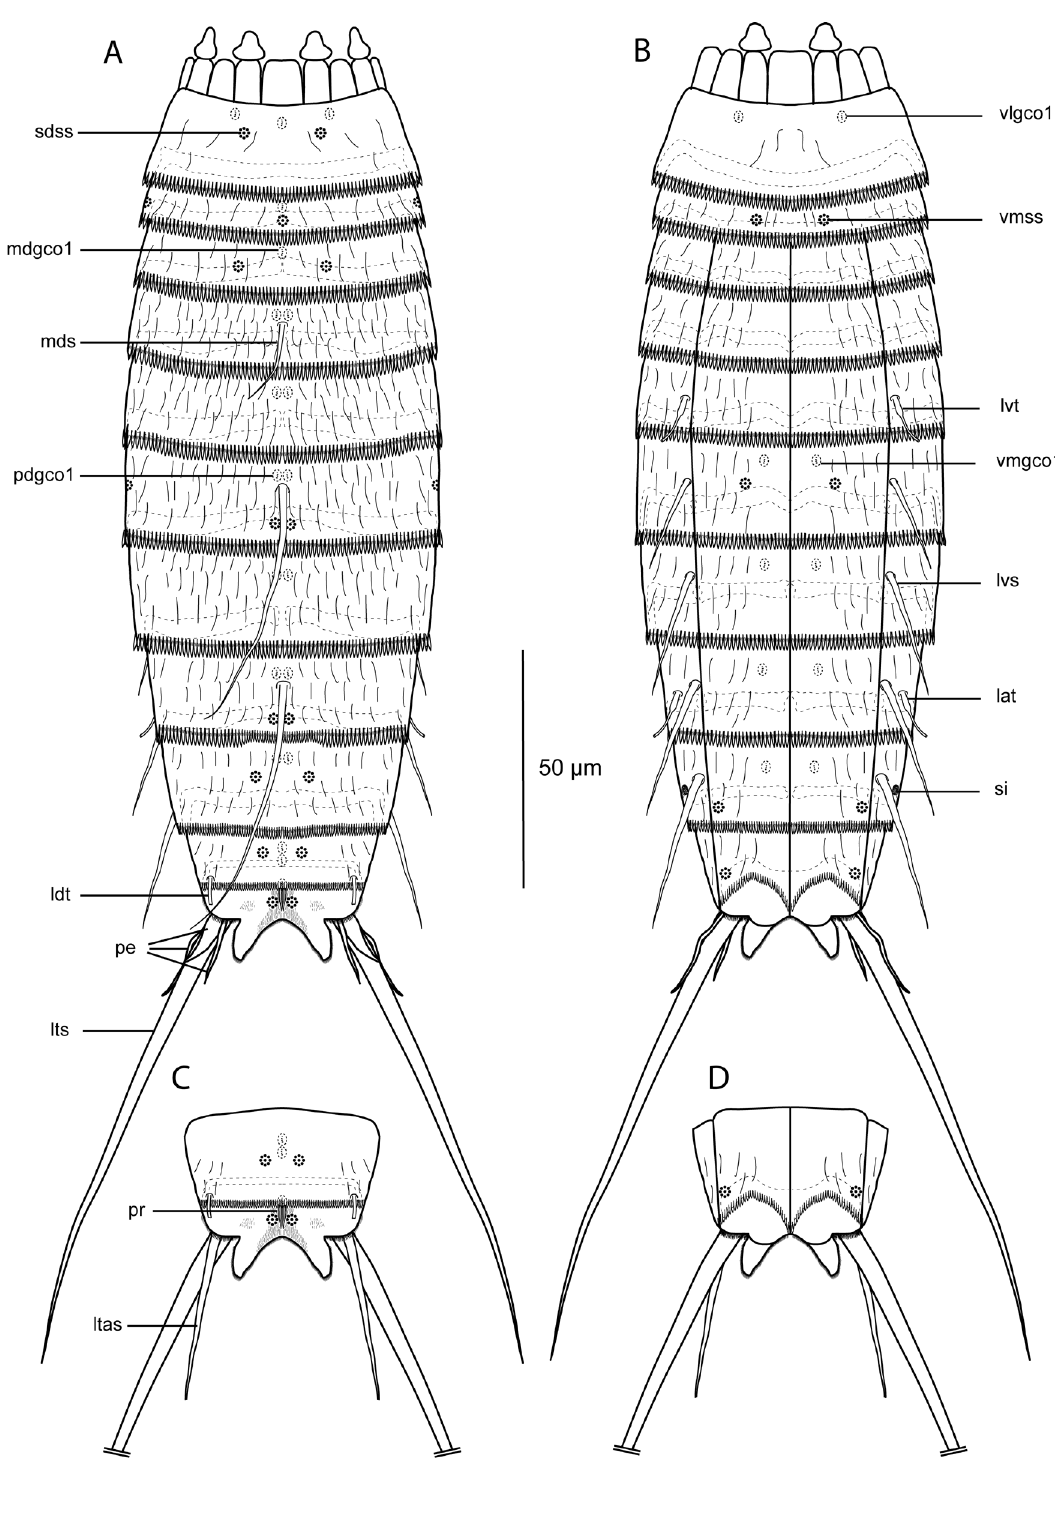
Fig. 20. Line art illustrations of Echinoderes samwisei sp. nov. A . ♂, dorsal view. B . ♂, ventral view. C . ♀, segments 10–11, dorsal view. D . ♀, segments 10–11, ventral view. Abbreviations: see Material and